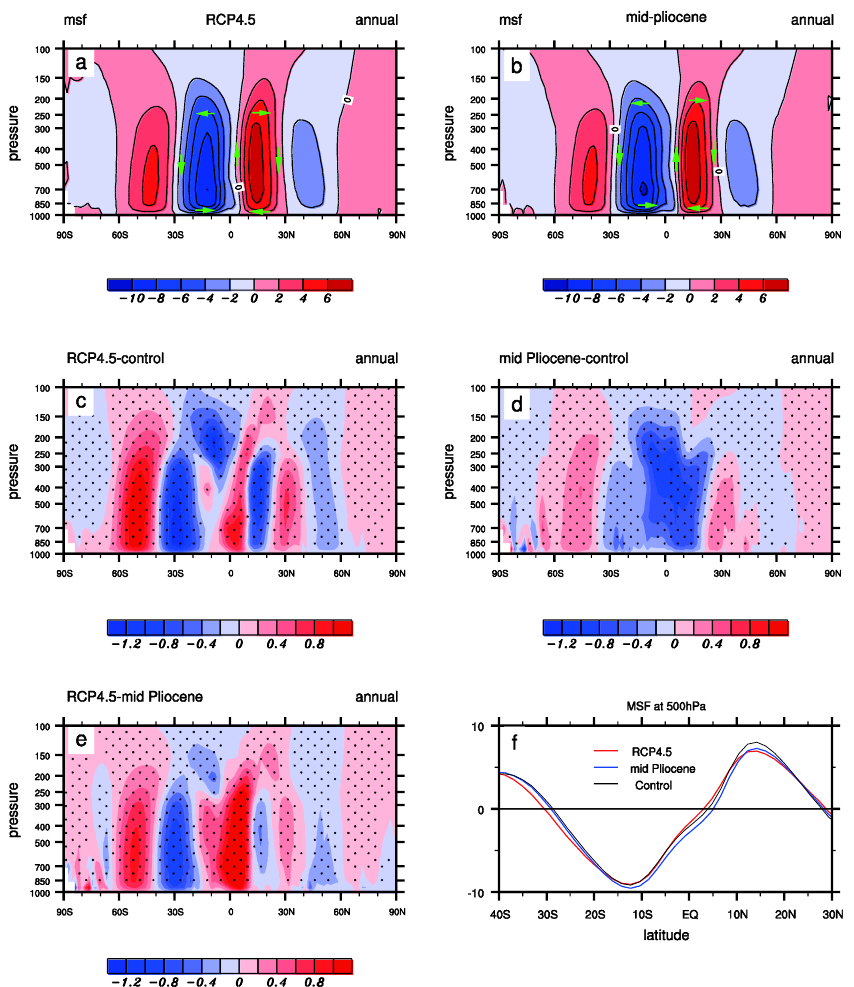
Fig. 1. Climatological annual average mass stream function (units: 10 10 kgs − 1 ) simulated by RCP4.5 (a) and mid-Pliocene (b) . Mass stream function changes in RCP4.5 and mid-Pliocene compared to the control run are displayed in (c, d) , respectively. Mass stream function differences between RCP4.5 and mid-Pliocene shown in (e) , and (f) represents mass stream function at 500hPa (red line: RCP4.5; blue line: mid-Pliocene; black line: control run). The dot area represents statistical significance with a 95% confidence.